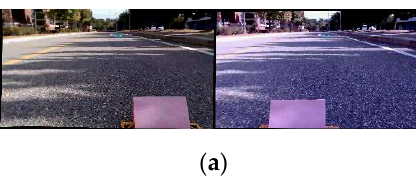
Figure 17. Test result images: ( a ) on the straight road, ( b ) on the curved road. Table 6. Test result analysis.